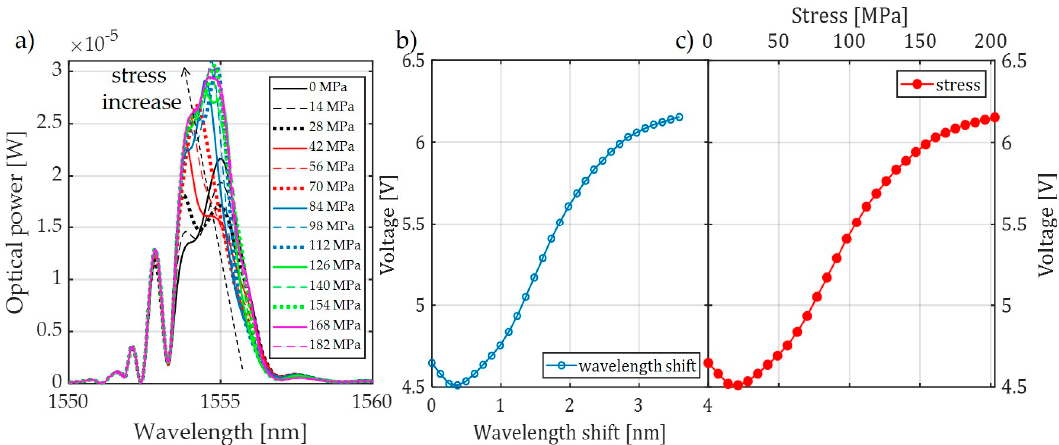
Figure 12. Measurement results in the interrogator system showed in Figure 3a for the FBG + FBGF2 matched gratings pair: ( a ) change in the shape of the system output signal due to stress change; ( b ) conversion characteristics of the wavelength shift into a voltage change measured on the photodetector; ( c ) the characteristics of the power line conductor stress conversion to change the voltage on the